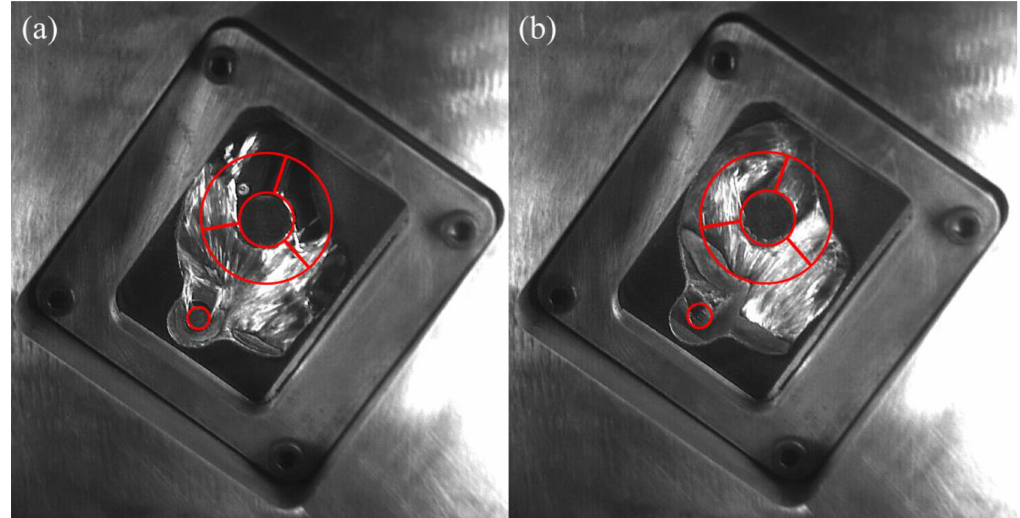
Figure 14. Flow pattern under the fast shot velocity of 2.34 m/s in the right window. ( a , b ) are arranged according to the order of